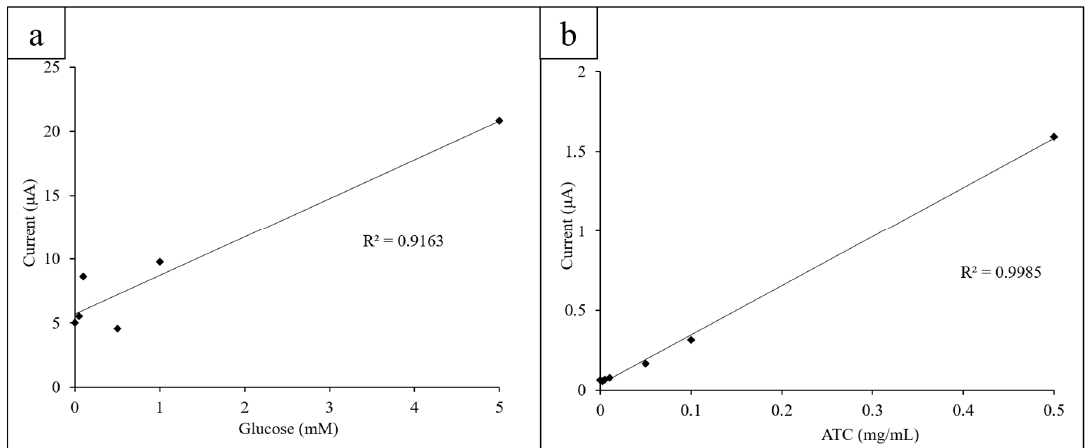
Figure 5. ( a ) Lower concentrations of glucose (0.025–1.000 mM) were measured to determine the LOD for glucose; ( b ) the lower concentrations of ATC (0.0025–0.5 mg/mL) were measured to determine